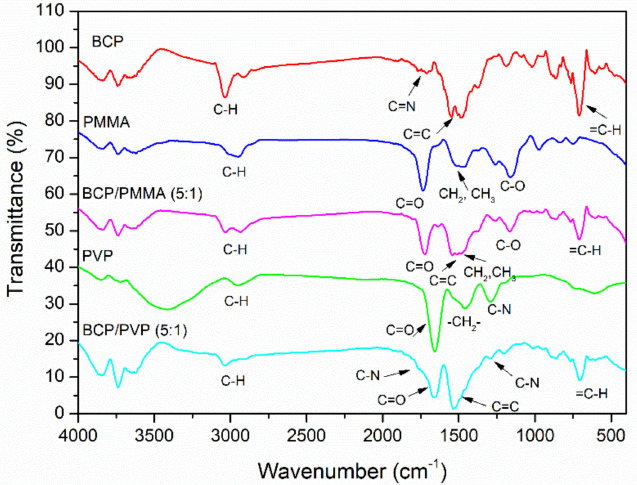
Figure 2. FTIR (Fourier transform infrared) spectra of bathocuproine (BCP), poly(methyl methacry- late) (PMMA), polyvinylpyrrolidone (PVP), BCP/PMMA (5:1, w / w ), and BCP/PVP (5:1, w / w